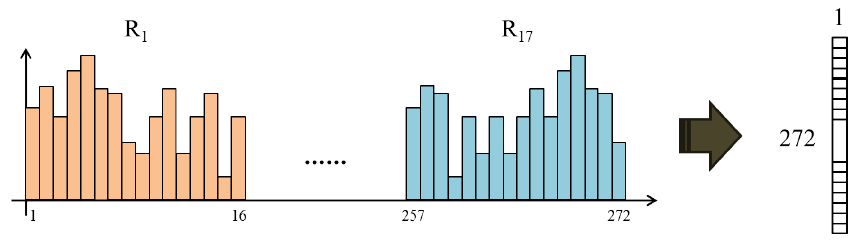
Figure 17. A histogram from one image